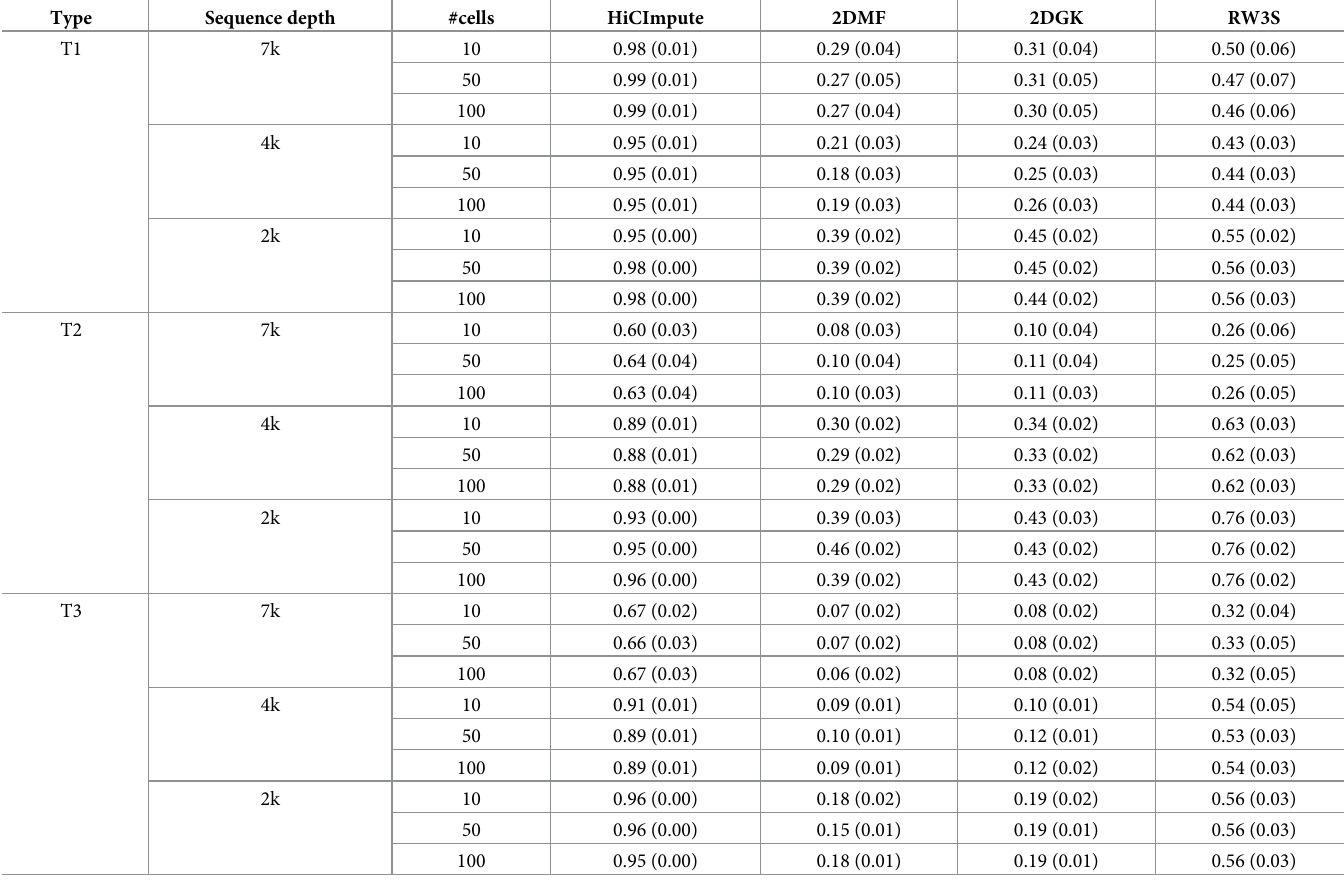
Table 1. Mean (standard error) of the proportion of true dropouts (PTDO) correctly detected when the detection rate for the proportion of true structural zeros (PTSZ) is set to be 0.95. Type Sequence